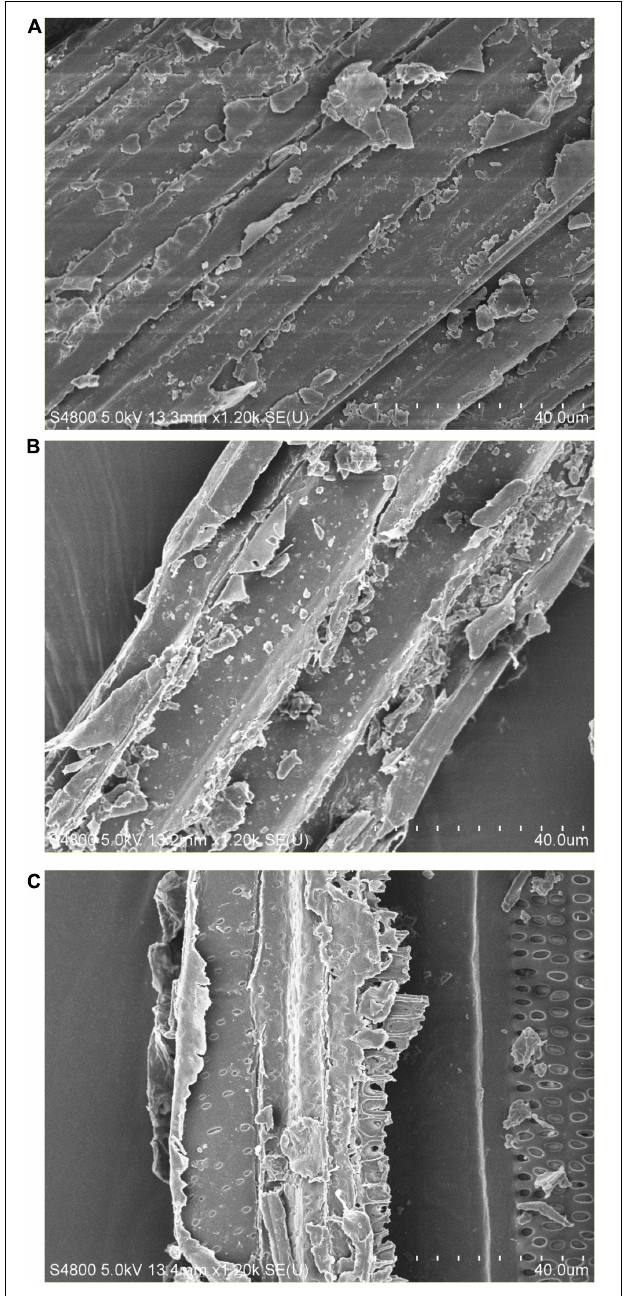
FIGURE 3 | Scanning electron microscopy of (A) untreated Phragmites karka , (B) acid-pretreated P. karka , and (C) saccharified Phragmites karka.